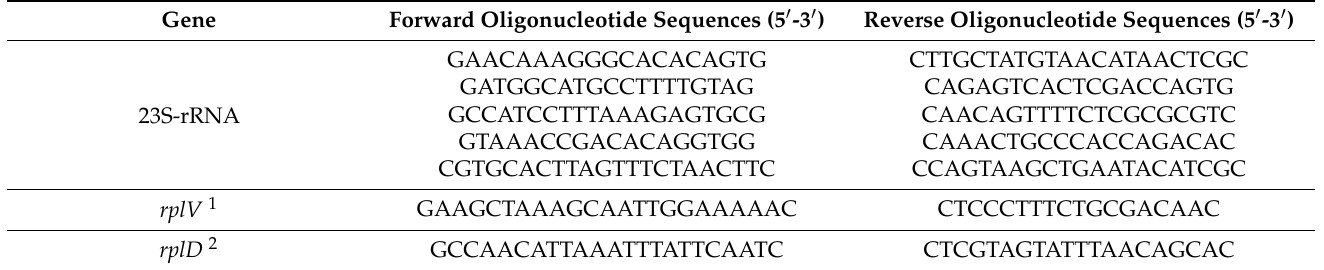
Table 3. Primers used in the study for PCR and sequencing. Gene Forward Oligonucleotide Sequences (5 (cid:48) -3 (cid:48)